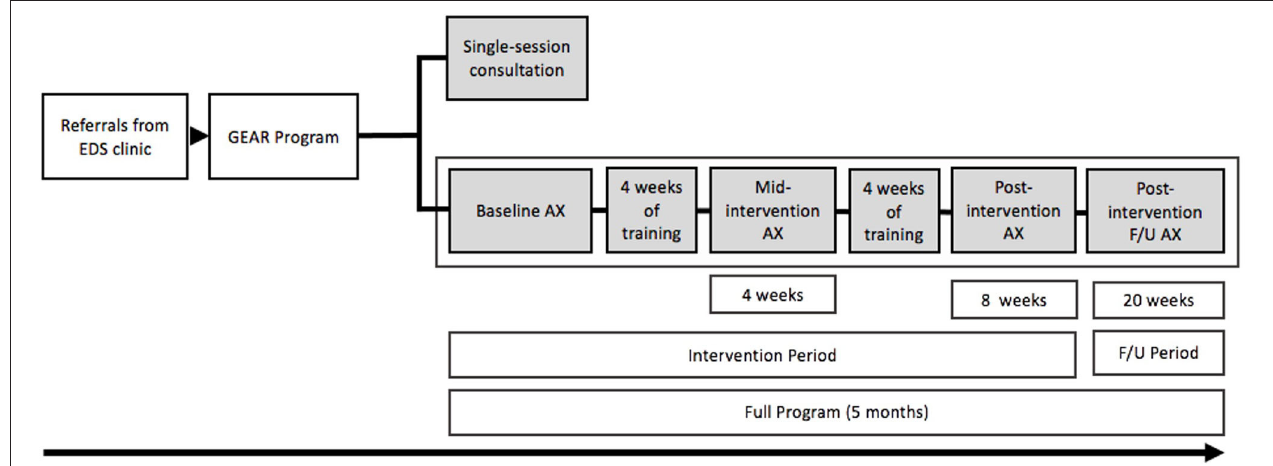
FIGURE 1 | Depiction of the GEAR program and the full program time line of the intervention, assessments (AX), and follow up (F/U).